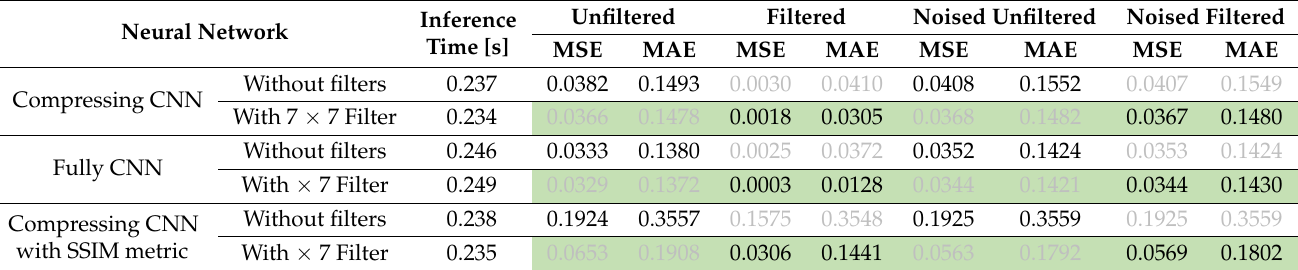
Table 1. Comparison of Neural network performance over test set. Green background determines the better results, while gray font means that the neural network was not trained for this task (filtered versus unfiltered